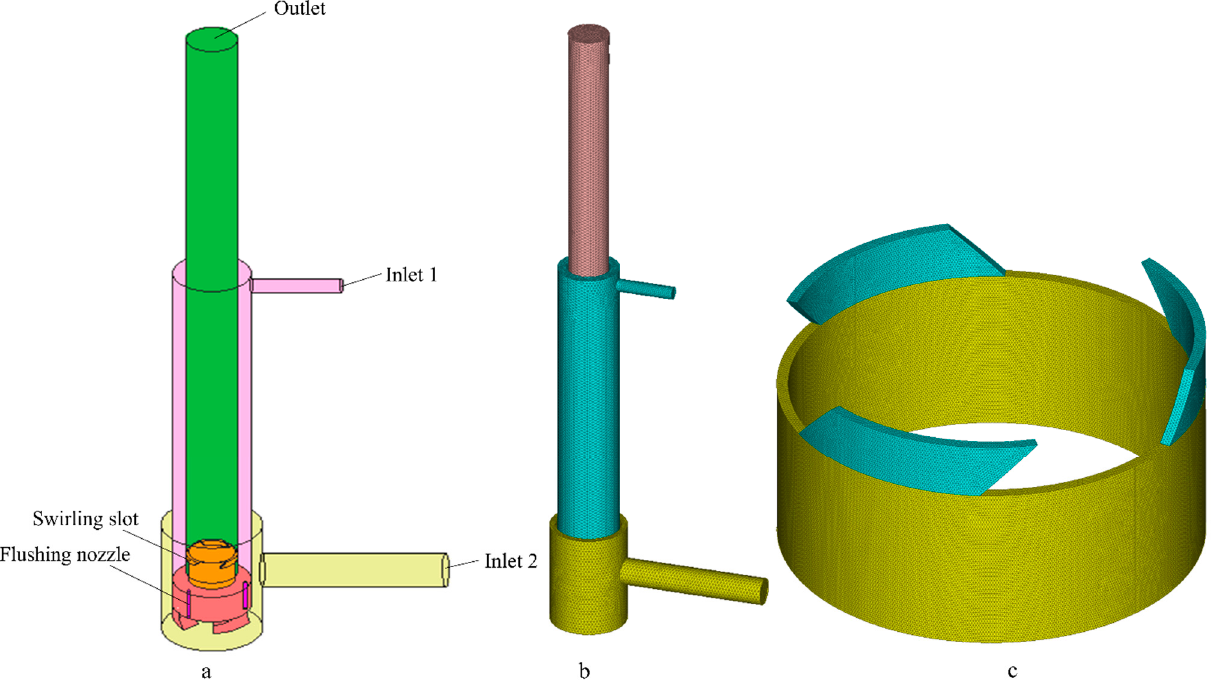
Figure 3. Reverse circulation drill bit: ( a ) physical model; ( b ) integral mesh; ( c ) mesh of the swirler.